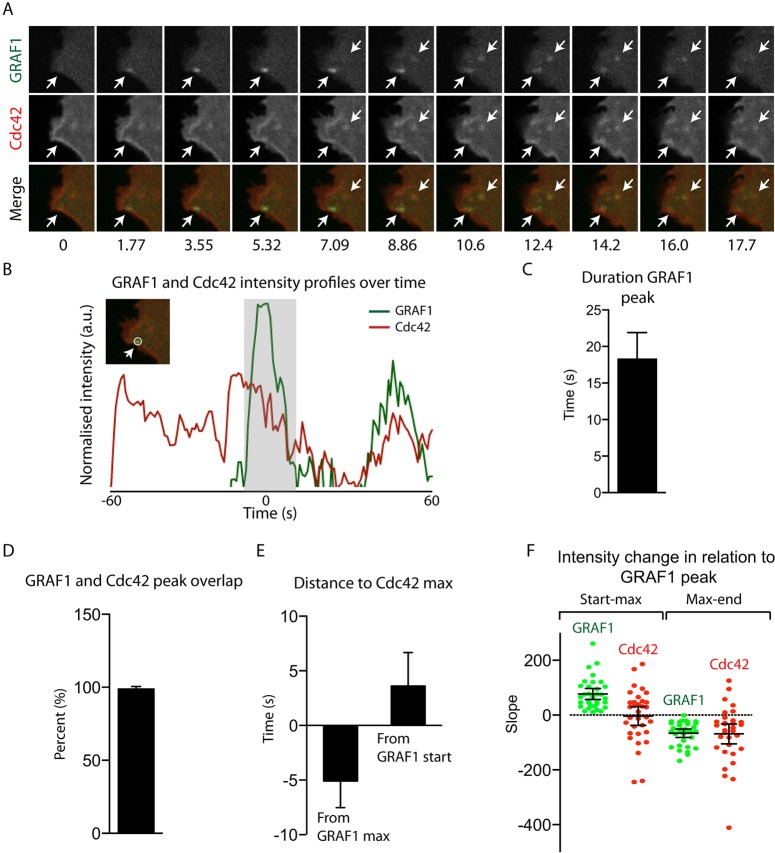
GRAF1 recruitment to Cdc42 microdomains coincides with a local decreasing plasma membrane association of the GTPase. (A) Time series from a live-cell spinning disc confocal microscopy acquisition, visualising a protrusion from a Flp-In T-REx HeLa GRAF1–GFP cell co-expressing mCherry–Cdc42. White arrows mark detected GRAF1 assemblies. (B) Intensity profiles of the green and red channels, calculated over time as described in the Materials and Methods, for the first-appearing GRAF1 assembly in A. The grey area highlights the peak duration for the green channel. The insert visualises the ROI used to derive the plotted fluorescence intensity curves. (C–F) Parameters calculated for single GRAF1 assemblies on the basis of the corresponding intensity peak recorded within the intensity profiles derived from live-cell acquisitions, as exemplified in A and B. The time points for the intensity peak start, maximum and end were defined for each structure and channel as described in the Materials and Methods. 34–36 GRAF1 structures from three cells were included in the analysis and results are mean±s.d.